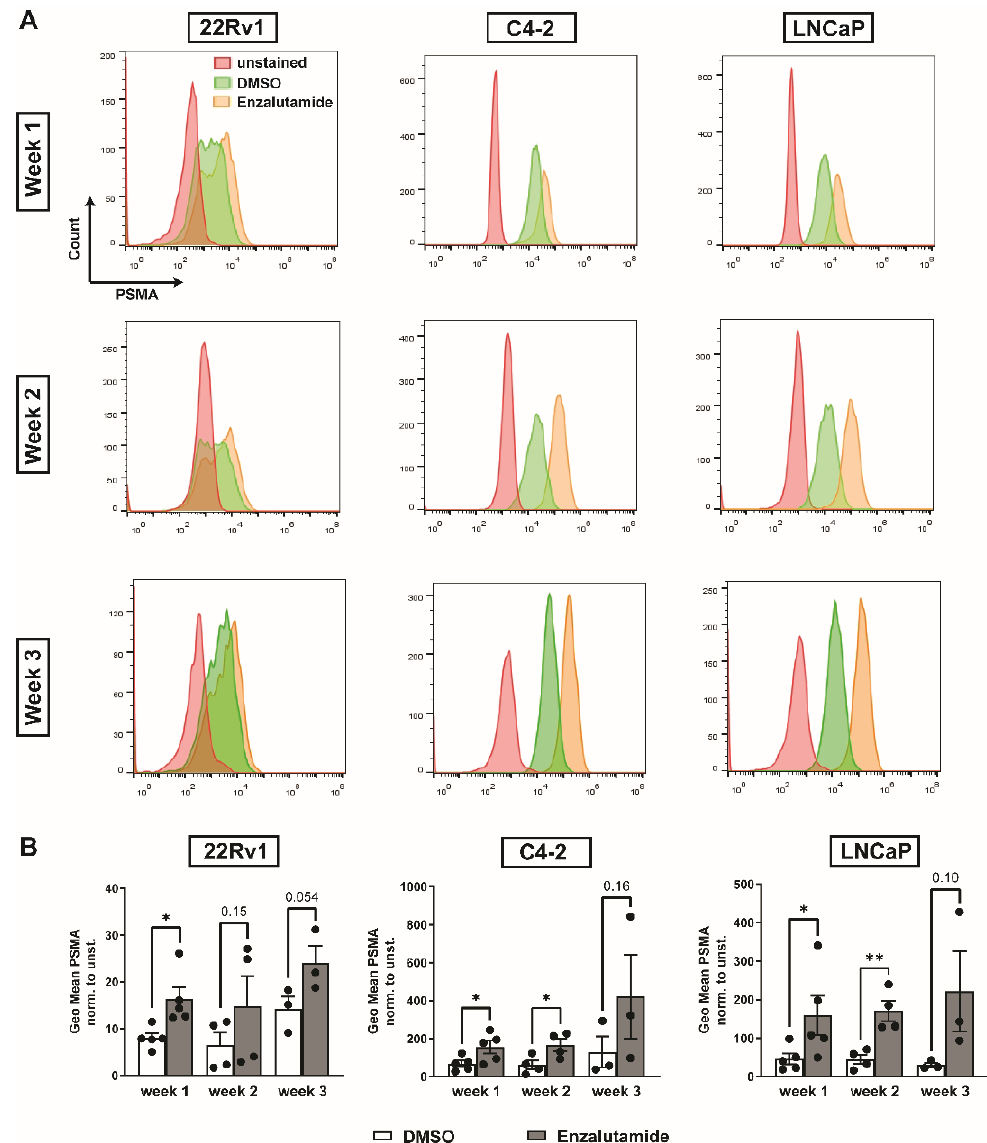
Figure 2. In vitro PSMA expression after enzalutamide treatment over time measured by flow cytometry. ( A ) Representative histograms of unstained and PSMA-stained DMSO-treated or enzalutamide-treated 22Rv1, C4-2 and LNCaP cells. Cells were treated for one, two, or three weeks. ( B ) Enzalutamide treatment significantly increased PSMA levels in 22Rv1, C4-2, and LNCaP cells after one week compared to DMSO-treated controls as assessed by flow cytometry; PSMA levels remained increased in all three cell lines two and three weeks after treatment initiation. Data are shown as geometric mean normalized to unstained control. Statistics: unpaired t -test with Welch’s correction; * p ≤ 0.05; ** p ≤ 0.01.